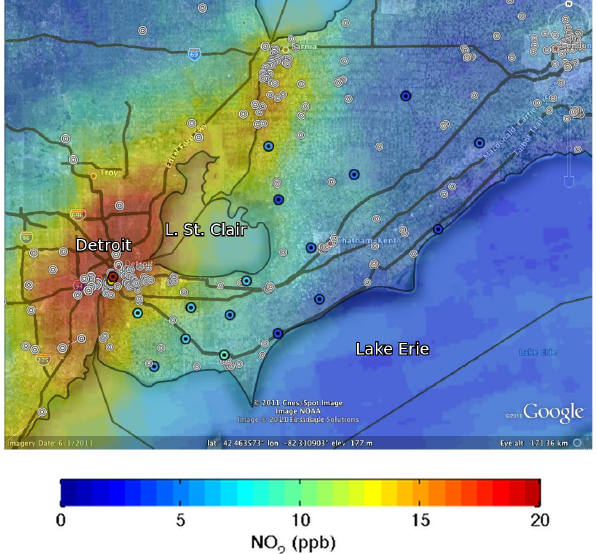
Fig. 8. Map of the campaign area with passive monitoring site campaign averages and emissions sources. Colour indicates OMI- inferred NO 2 . The passive sites are marked by coloured circles with the colour of the circle representing the campaign average NO 2 con- centration (same colour scale as map). US EPA emissions sources with 2005 emissions greater than 100t NO x /yr are marked on the US side, while Environment Canada NPRI emissions greater than 100t NO 2 /yr are marked.